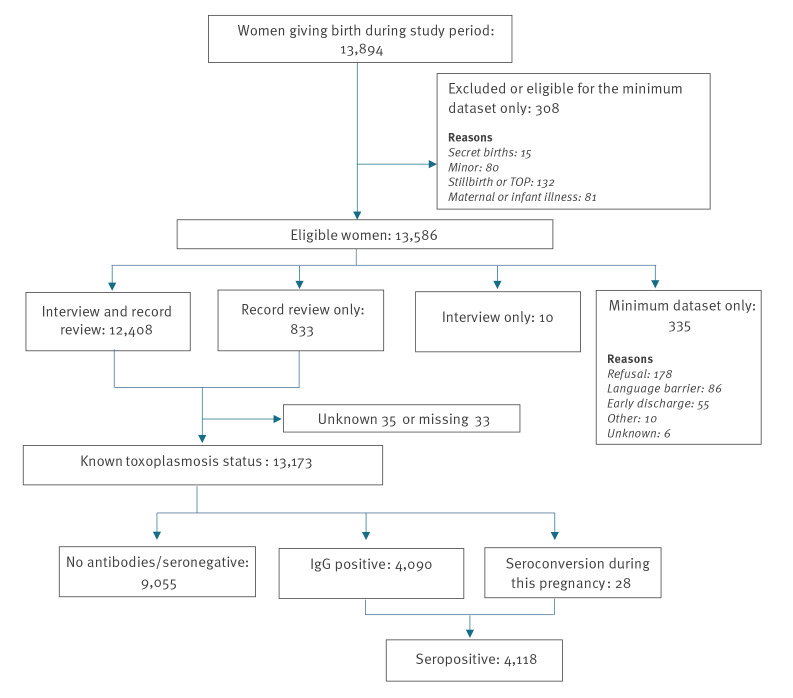
Flowchart of the national perinatal survey population, France, 2016 (n = 13,173)